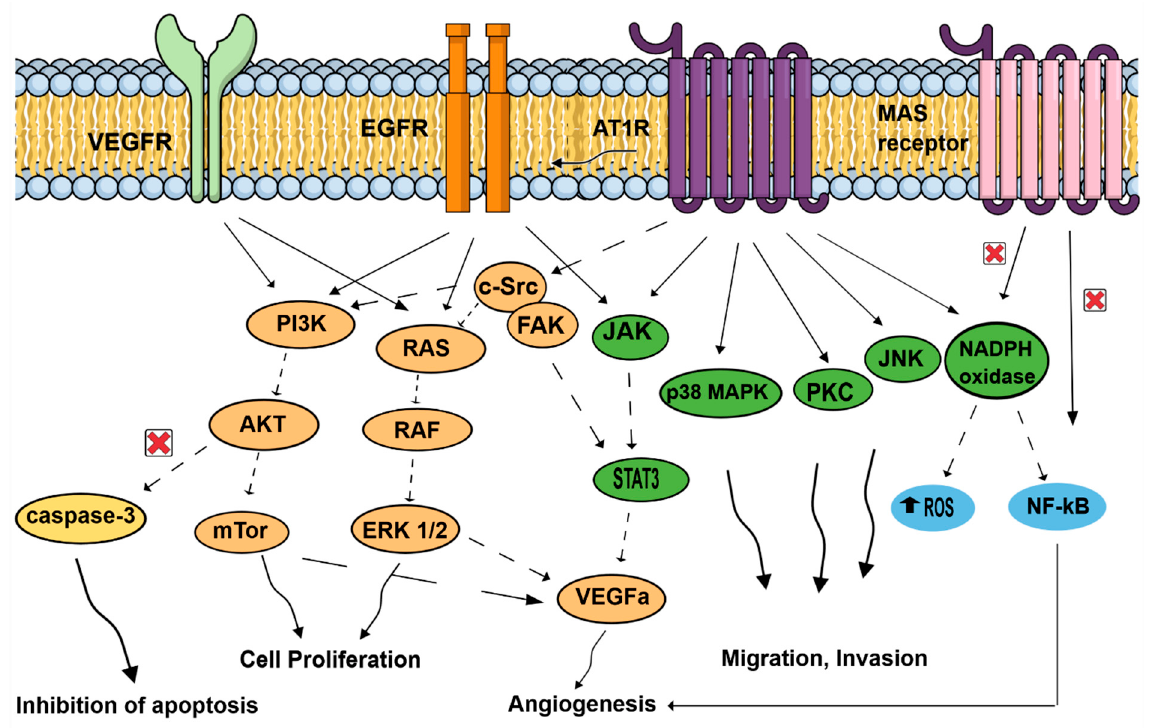
Figure 3. Signal transduction pathways induced by the renin–angiotensin system, associated with cell proliferation, migration, invasion, inhibition of apoptosis, and angiogenesis. AT1R: angiotensin II receptor type 1; AKT: protein kinase B; c-SRC: non-receptor tyrosine kinase c-SRC protein; EGFR: epidermal growth factor receptor, JAK: Jun activating kinase; JNK: Jun N-terminal kinase; MAPK: mitogen-activated protein kinase; mTor: mechanistic target of rapamycin; NADPH oxidase: nicotinamide adenine dinucleotide phosphate oxidase; NF κ B: nuclear factor κ B; PI3k: phosphoinositide 3-kinase; ROS: reactive oxygen species; STAT3: signal transducer and activator of transcription 3; VEGFA: vascular endothelial growth factor A; VEGFR: vascular endothelial growth factor receptor.